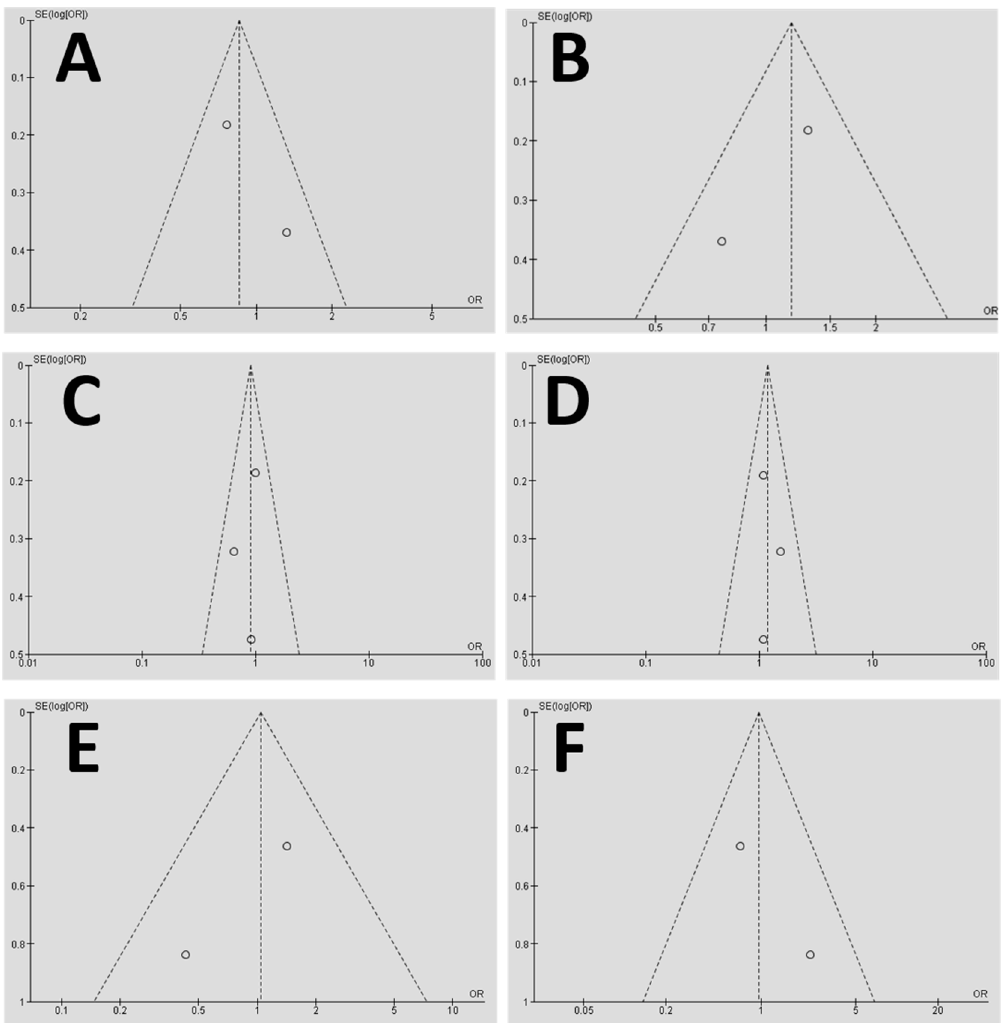
Figure 8. A funnel graph for the homogeneity representation of the meta-analysis. The data shows that the plotted homogeneity is acceptable for the DNA alleles used in the meta-analysis, including the IL1B-C allele study group ( A ), IL1B-T allele ( B ), IL10-G allele ( C ), IL10-A allele ( D ), TNF α -A allele ( E ), and TNF α -G allele ( F ). SE (log[OR]) = standard error of the natural logarithm of the odds ratio.